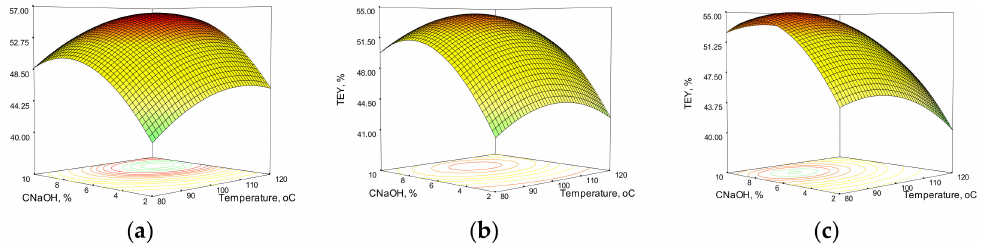
Figure 2. Response surfaces and contour plots of the combined effects of sodium hydroxide con- centration and temperature on total extraction yield from wheat straw at various reaction times: ( a ) 60 min; ( b ) 90 min; ( c ) 120